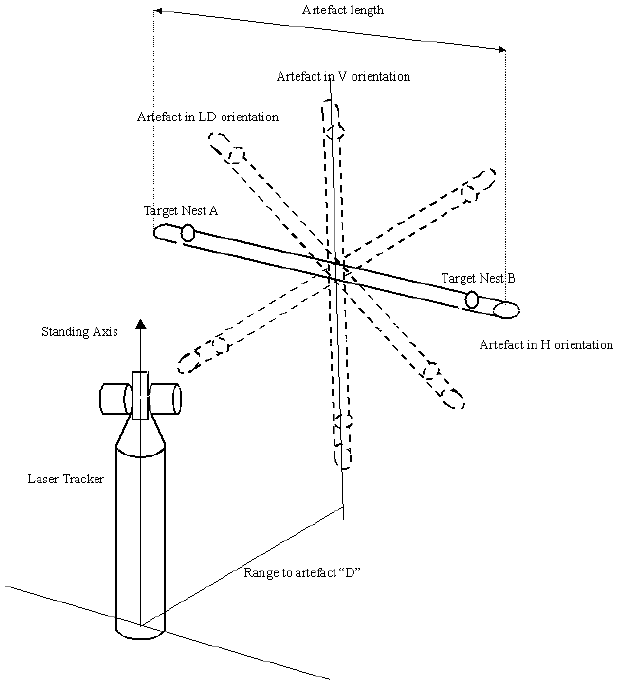
Fig. 4. Illustrations of the four B89 main test configurations.